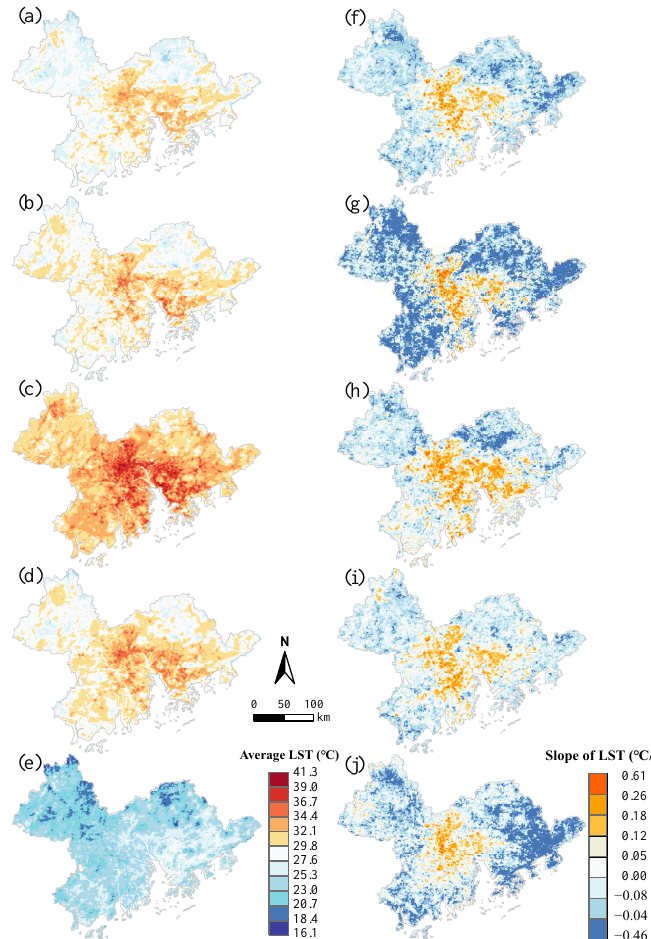
Figure 2. The annual and seasonal mean and slope of LST in the GHM−GBA region: ( a ) annual average LST; ( b ) spring average LST; ( c ) summer average LST; ( d ) autumn average LST; ( e ) winter average LST; ( f ) slope of annual LST; ( g ) slope of spring LST; ( h ) slope of summer LST; ( i ) slope of autumn LST; ( j ) slope of winter LST.